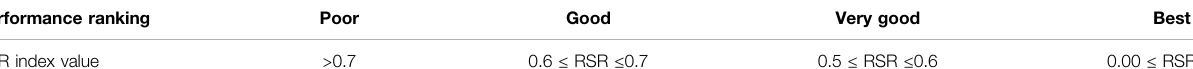
TABLE 2 | Performance ranking and the corresponding RSR index values. Performance ranking